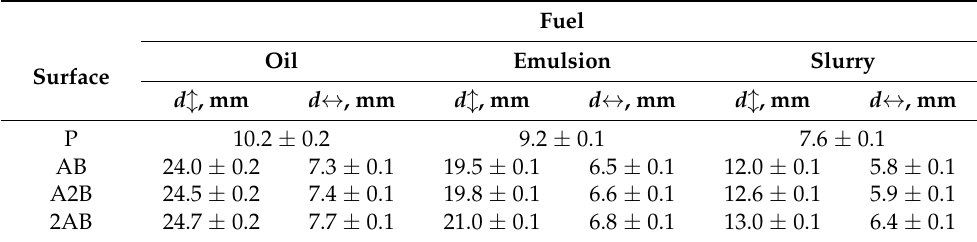
Table 3. Contact diameters of fuel droplets measured during droplet spreading parallel ( d (cid:108) ) and perpendicular ( d ↔ ) to microchannels on steel